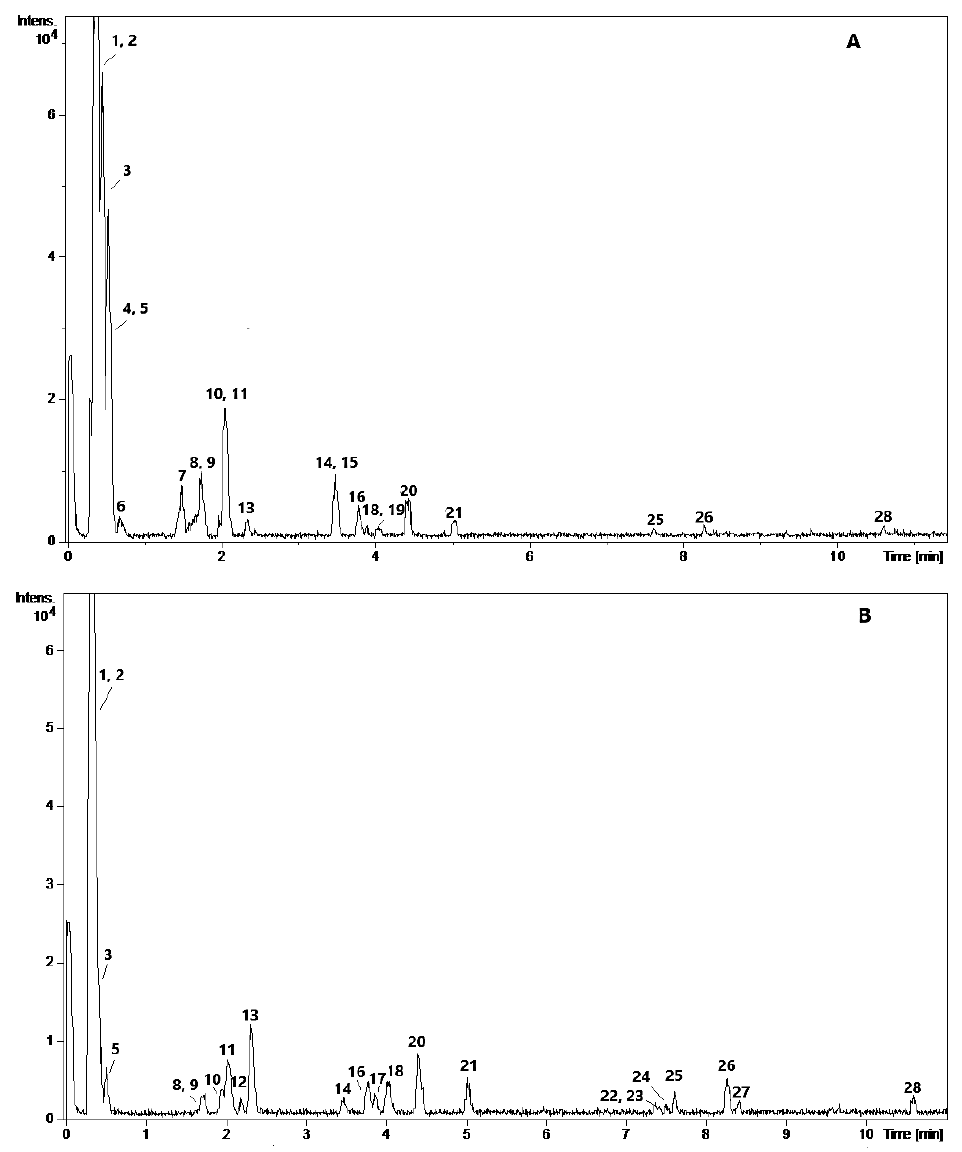
Figure 1. Representative UPLC-QTOF-MS chromatograms of water ( A ) and ethanol ( B ) extracts of